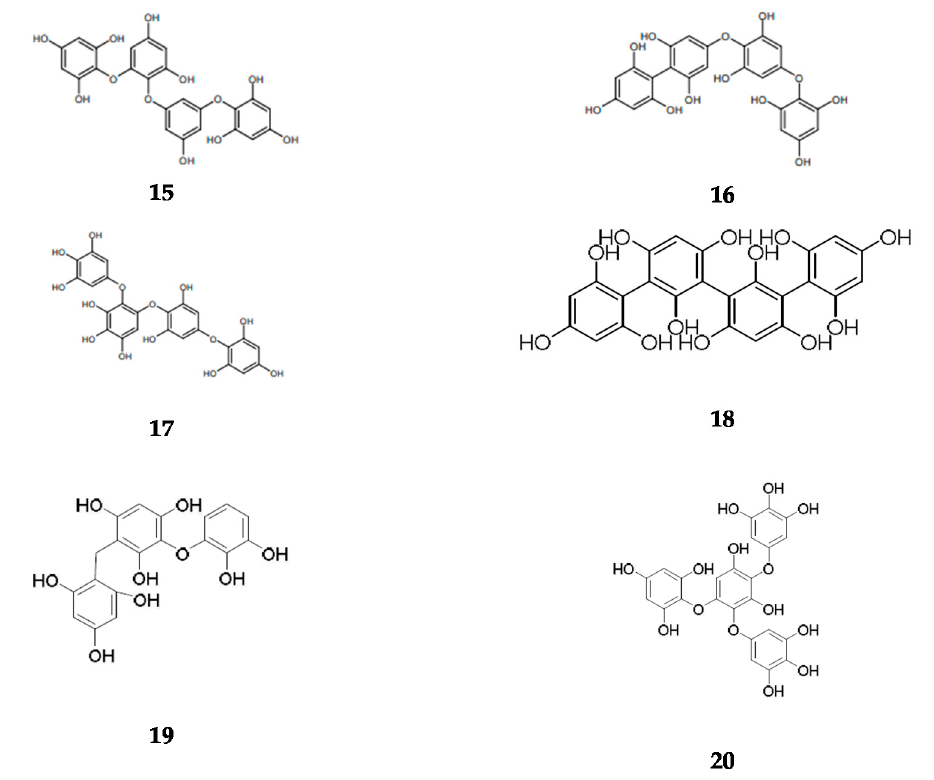
Figure A1. Phloroglucinol ( 1 ), dieckol ( 2 ), eckstolonol ( 3 ), triphlorethol A ( 4 ) [14], eckol ( 5 ) [10], dioxinodehydroeckol ( 6 ), 7-phloroeckol ( 7 ) [24], 1-(3 ′ ,5 ′ -dihydro-xyphenoxy)-7-(2 ′ ,4 ′ ,6 ′ -trihydroxyphenoxy)-2,4,9-trihydroxydibenzo-1,4-dioxin ( 8 ), 6,6 ′ -bieckol ( 9 ) [17], fucodiphloroethol G ( 10 ) [62]. phlorofucofuroeckol A ( 11 ) [62], diplorethol ( 12 ), difucol ( 13 ) [44], tetrafucol A ( 14 ), tetraphlorethol B ( 15 ), fucodiphlorethol A ( 16 ), tetrafuhalol A ( 17 ), trifuco ( 18 ), fueodiphlorethol C ( 19 ), and bifuhalol B ( 20 ) [25].